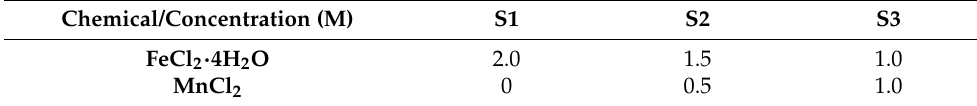
Table 1. Composition of the three electrolytes